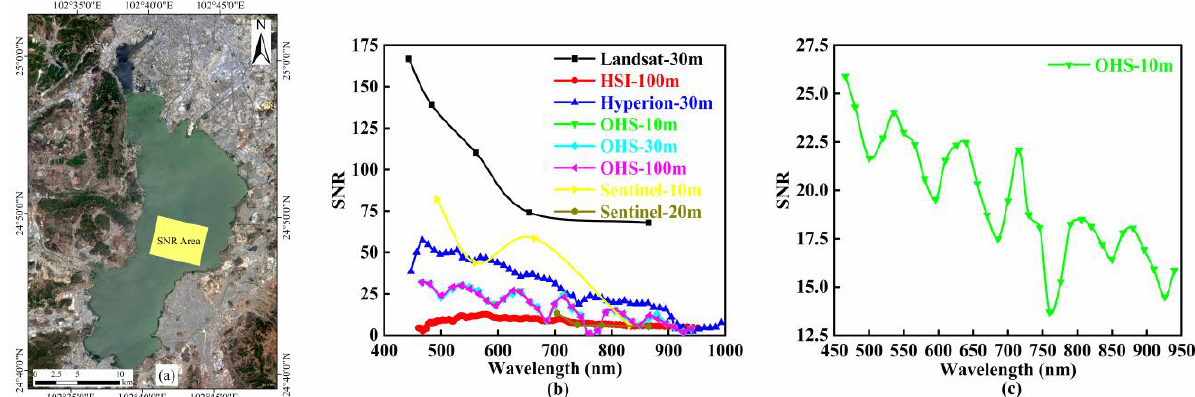
Figure 6. The signal-to-noise ratio comparison between OHS image, Landsat-8 image, and HSI image. ( a ) indicates the selected SNR calculation area. ( b ) designates the SNR of different images (the black line is the SNR of the Landsat-8 image, the red line is the SNR of the HSI image, the blue line is the SNR of the Hyperion image, the green line is the SNR of the OHS image (spatial resolution of 10 m), the cyan line is the SNR of the OHS image (spatial resolution of 30 m), the pink line is the SNR of the OHS image (spatial resolution of 100 m), the yellow line is the SNR of the Sentinel-2 image (spatial resolution of 10 m), the brown line is the SNR of the Sentinel-2 image (spatial resolution of 20 m)). ( c ) denotes the stretched version of the SNR of the OHS imagery (spatial resolution of 10 m) in ( b ). Table 4. Comparison of the SNR of OHS image, Landsat-8 OLI image, HJ-1 HSI image, EO-1 Hyperion image, and Sentinel-2 MSI image for typical